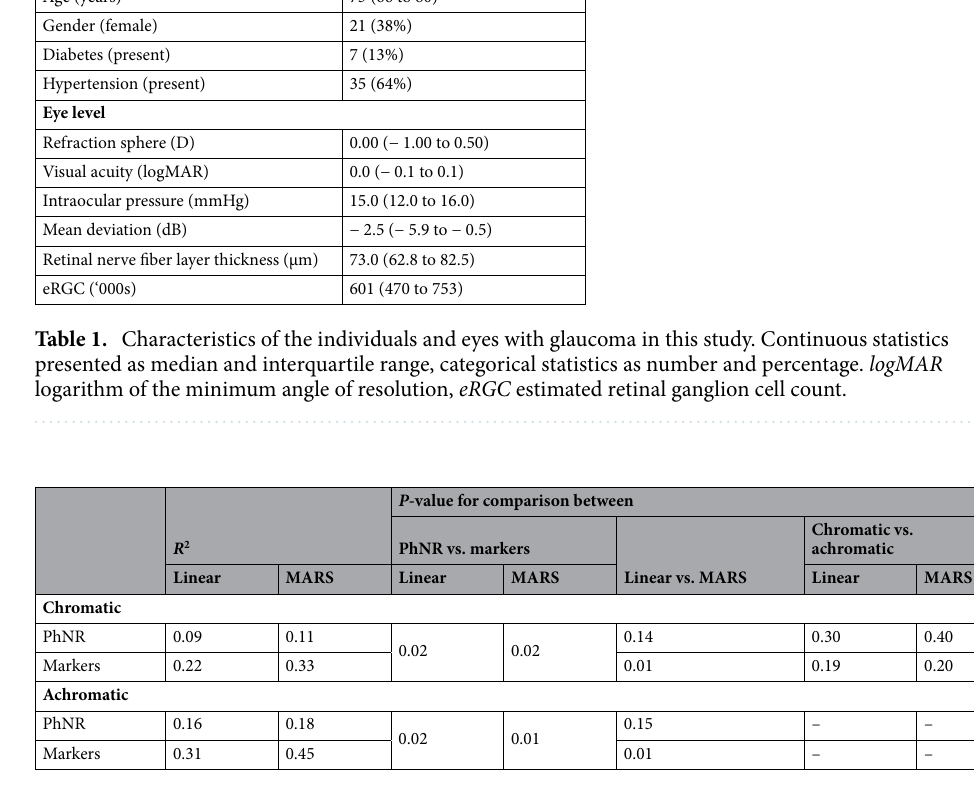
Table 2. Model performance as proportion of variance explained (R 2 ) for the prediction of ganglion cell count from models based on photopic negative response (PhNR) alone or the full set of amplitude features (“Markers”, including the a-, b- and i-waves and PhNR1 and PhNR2). Both simple linear regression and multivariate adaptive regression spline (MARS) models are shown. Testing was with red flashes on blue background (chromatic) or white on white (achromatic). P-values were calculated by bootstrap resampling.